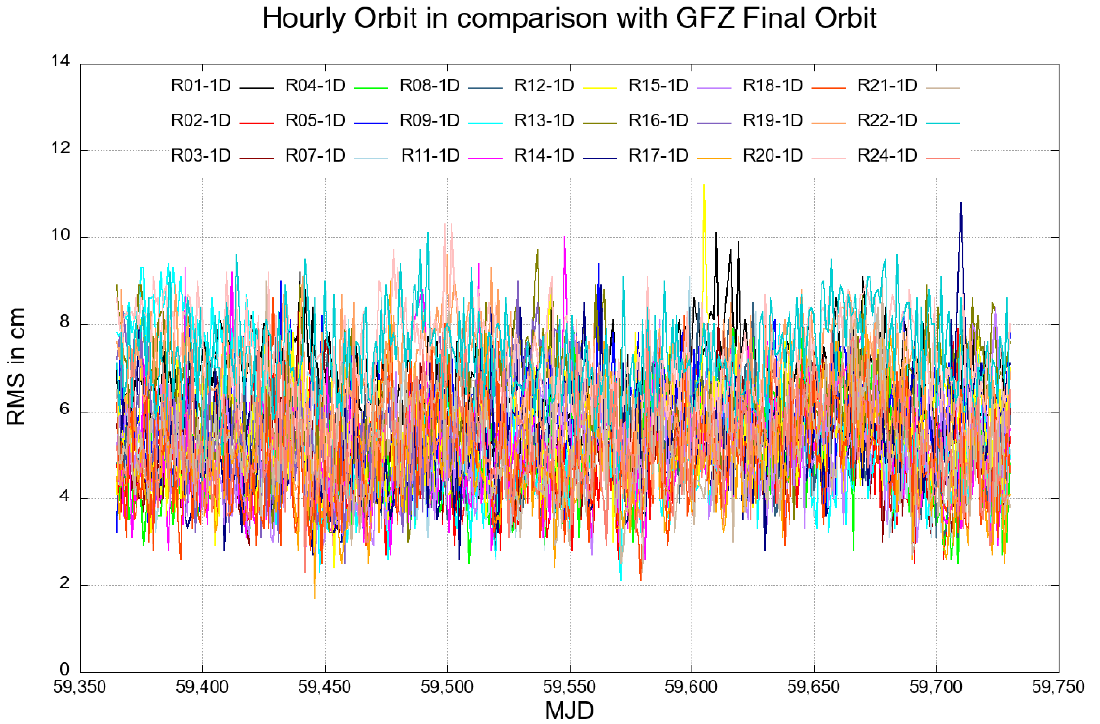
Figure 11. Time series in 1-D of GLONASS satellites compared with GFZ final orbit.